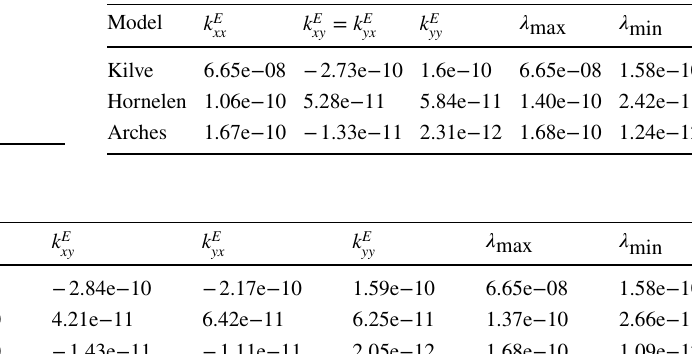
Table 5 Ensemble absolute permeability tensor components of the models when the symmetricity is